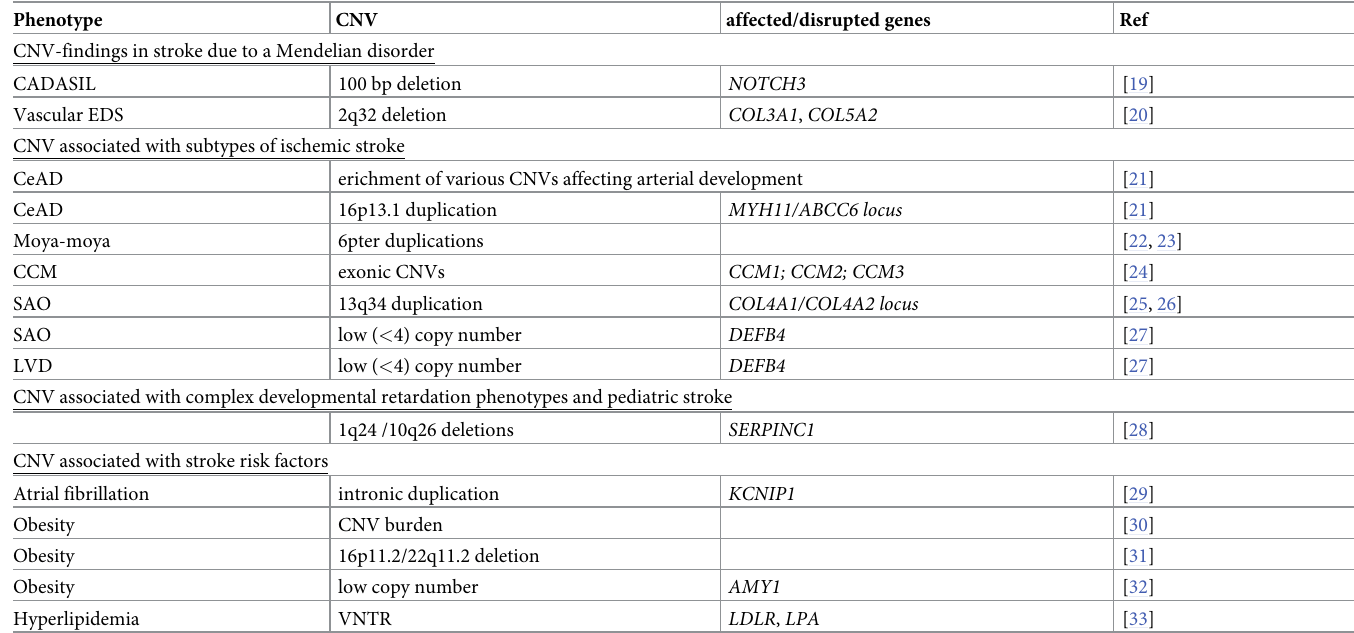
Table 1. CNV-findings associated with ischemic stroke.